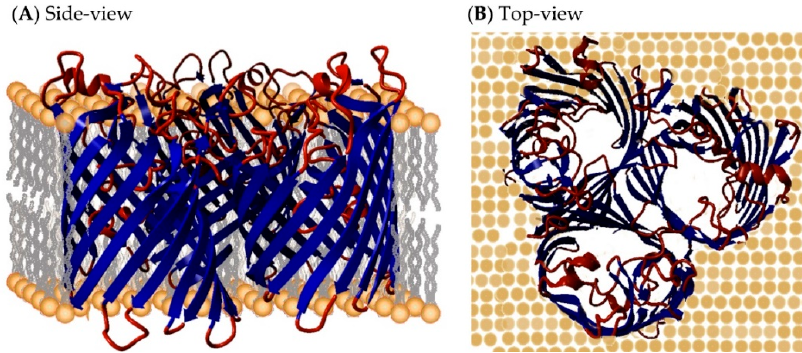
Figure 1. Outer membrane protein (OMP) structure. OMP structures are composed of a transmembrane motif that consists of β -strands that form a transmembrane β -barrel. These strands are connected by short loops (also called turns) in the periplasm and longer extracellular loops. The number of β -strands, the length of the β -strands and the loop lengths vary widely among OMPs. Here, the trimeric general diffusion porin (GDP) from E. coli (PDB (Protein Data Bank) ID: 2J1N, [4]) is shown as an example from ( A ) the side-view with the ß-barrel core embedded in the membrane and ( B ) the top-view, where the pores are visible viewed from the extracellular side. The β -barrel with loops and turns removed (blue) is referred to as the core.